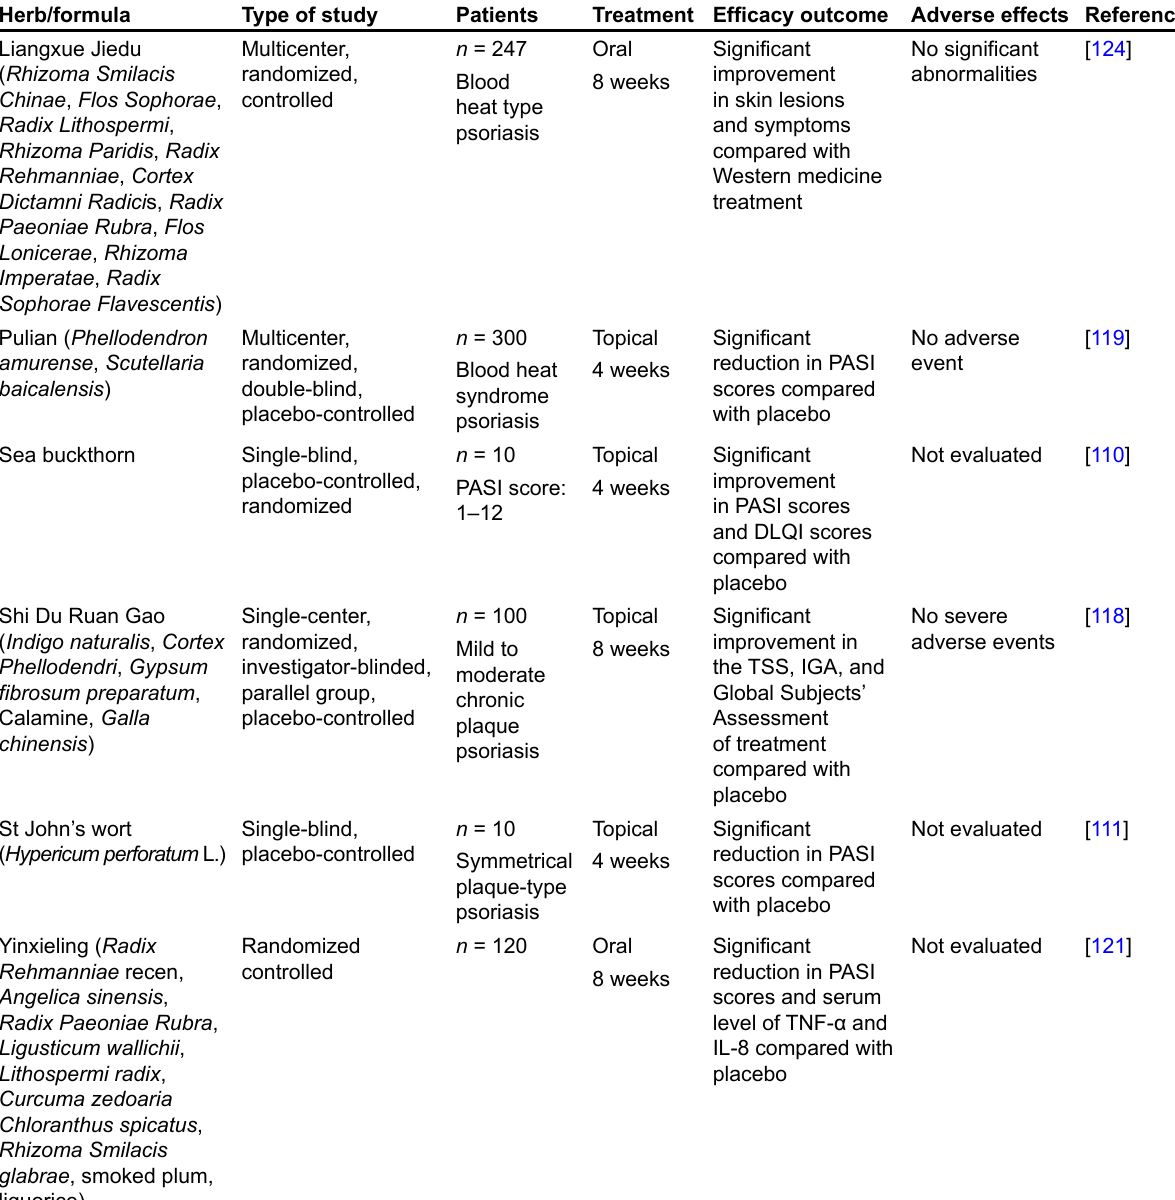
Table 4. Clinical efficacy of natural products ( continued